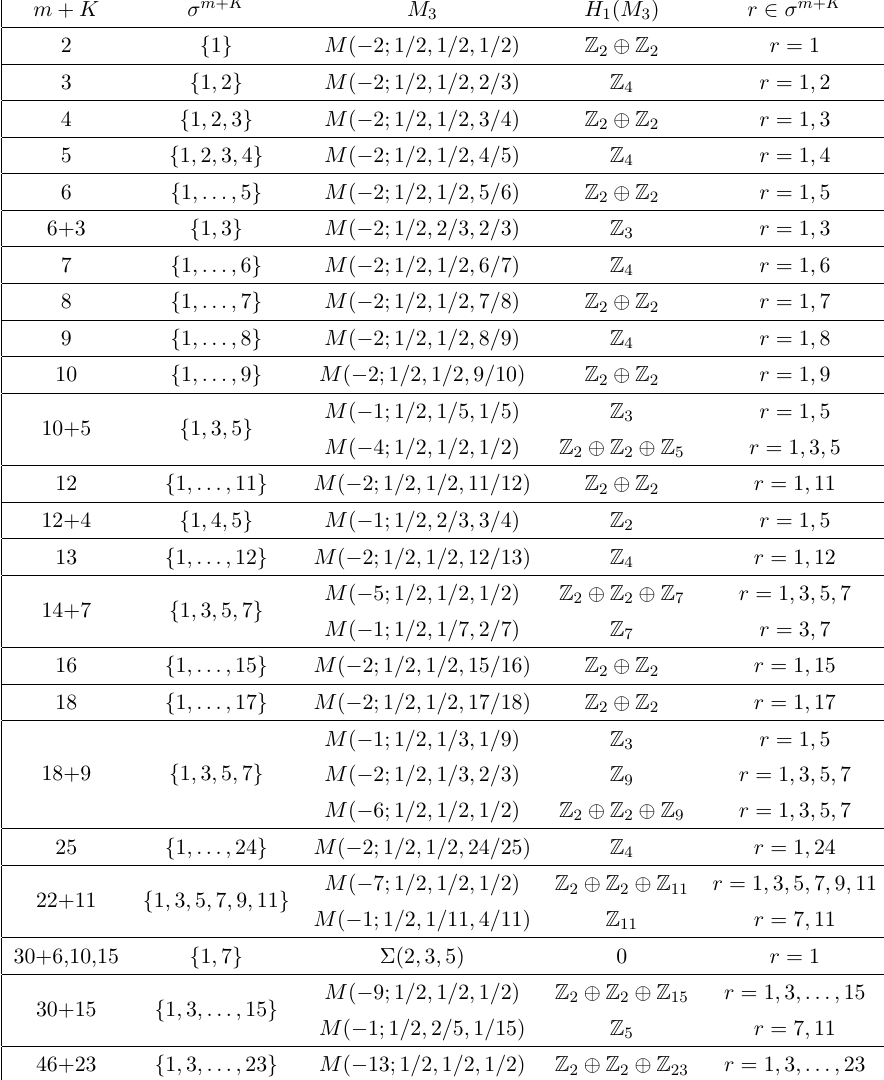
Table 13 . Optimal mock Jacobi thetas of Niemeier type and examples of the relevant 3-manifolds.